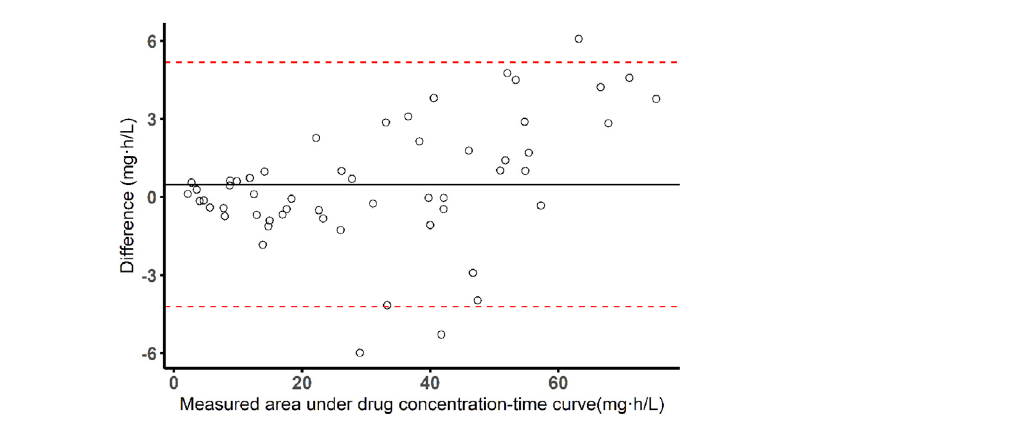
FIGURE 1 Bland-Altman plot of measured AUC versus predicted AUC values by Bayesian approach and limited sampling strategy (sampling time: 0, 2, 4, 6